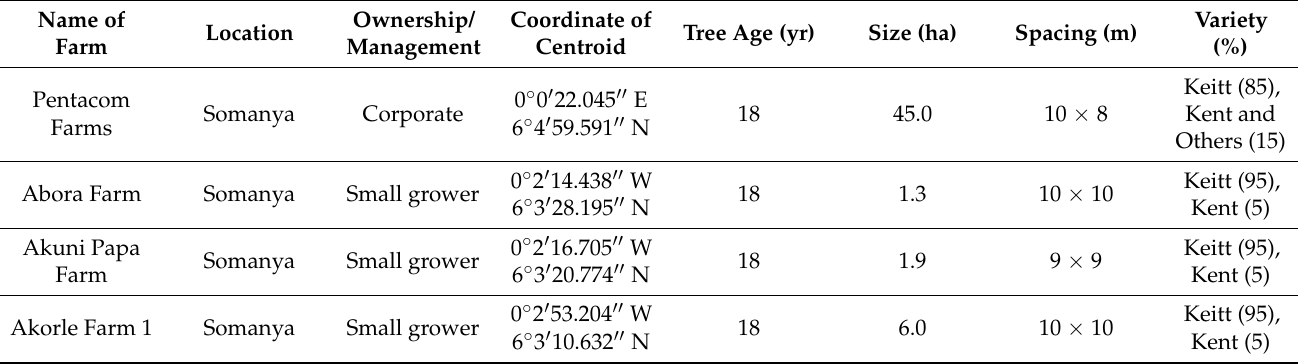
Table 1. Description of the four farms used in the study.